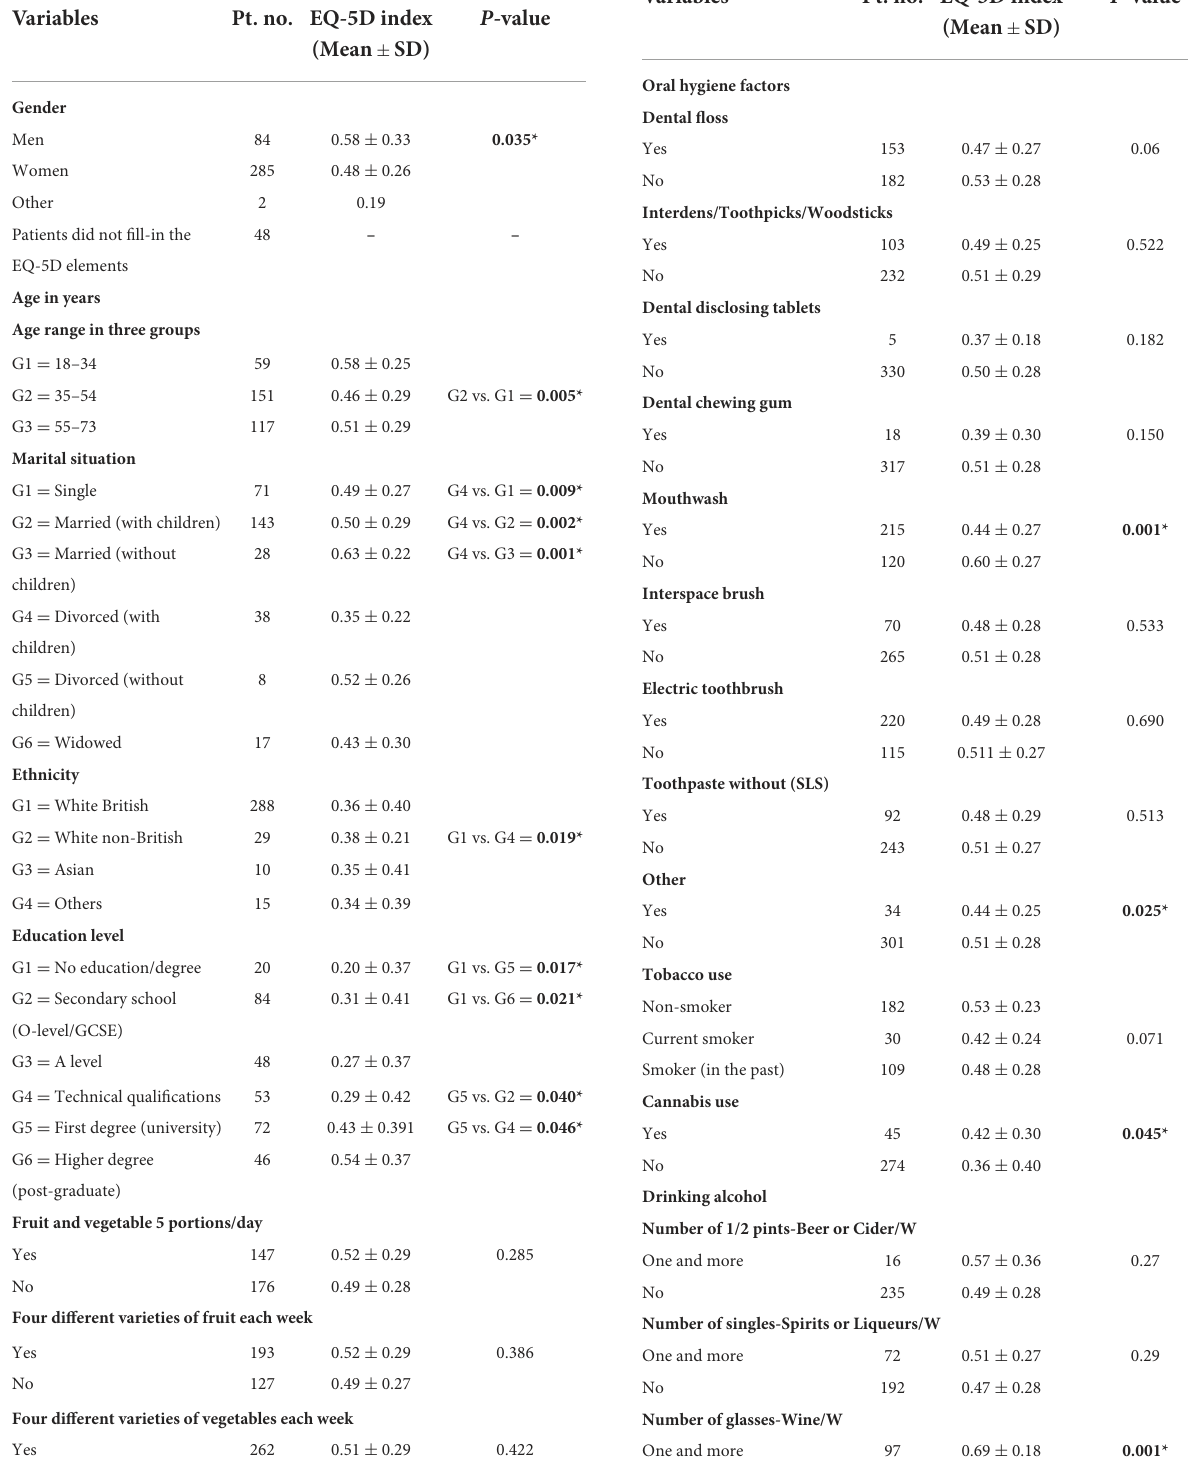
TABLE 1 Socio-demographic, lifestyle, career, and social benefits characteristics of BS patients and their EQ-5D scores ( n = 371).